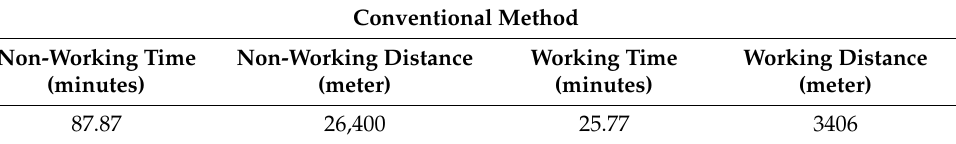
Table 7. The results of the conventional method.